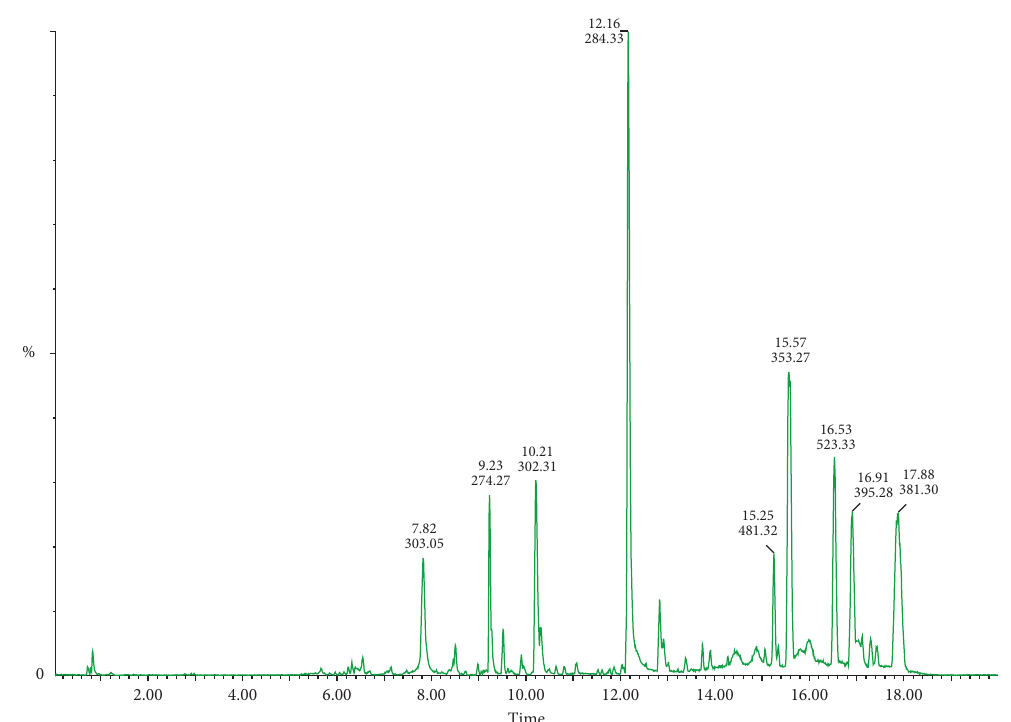
Figure 9: HPLC peaks of compounds identified by